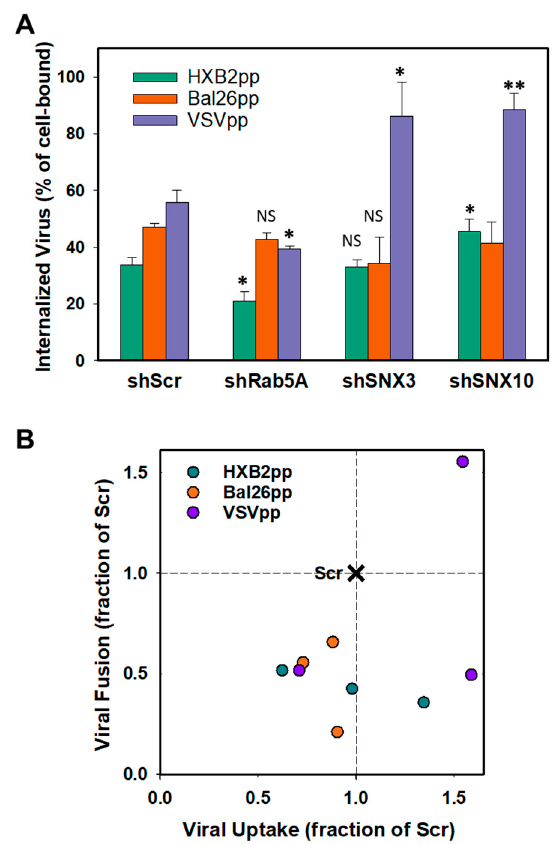
Figure 4. Effect of protein knockdown on virus uptake by cells. ( A ) Rab5A, SNX3 and SNX10 were knocked down in CEM.CCR5 cells and the ability of shRNA-transduced cells to internalize HXB2pp, Bal26pp or VSVpp was measured after stripping of cell surface-associated virus with trypsin 1 h post-inoculation (see Methods). The fraction of internalized virus for each condition is plotted. The data points are means and SEM from two independent triplicate experiments. *, P < 0.05; **, P < 0.01; NS, not significant. ( B ) Correlation between virus uptake by and fusion with CEM.CCR5 cells depleted of Rab5A, SNX3 or SNX10 (data from Figures 2B and 4A) plotted as fractions of the shScr control.